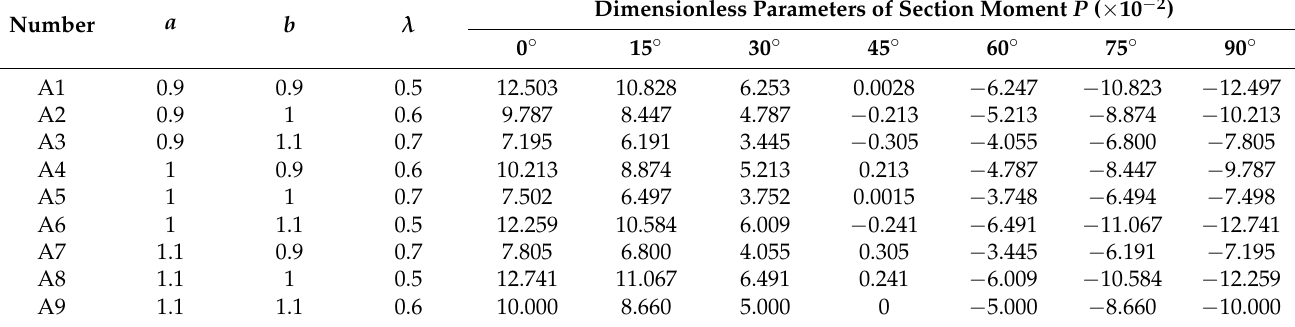
Table 6. Section moment of functionally graded lining.